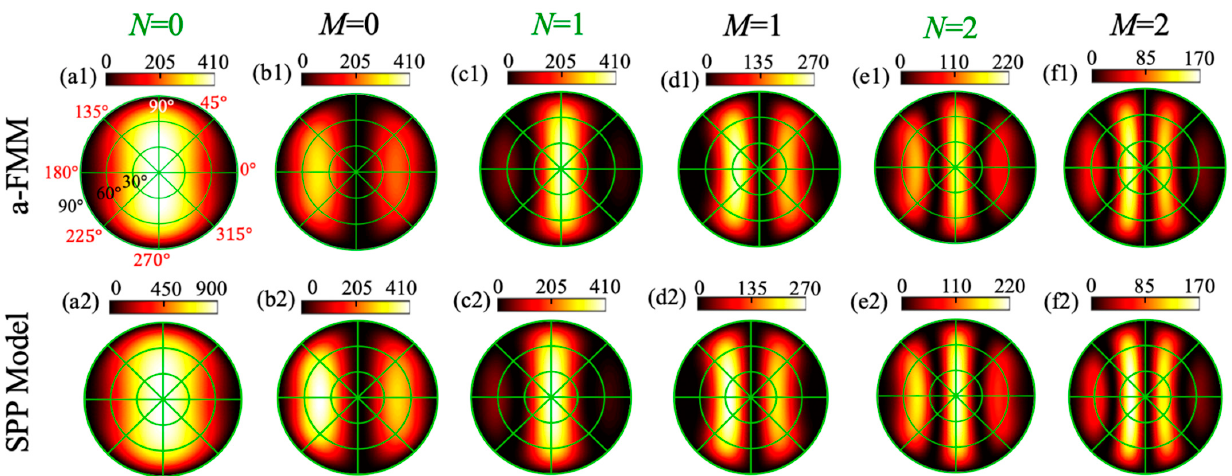
Figure 6. Angular distributions of the far-field emission P ( θ , ϕ ) of the rectangular-aperture nanoantenna obtained at the antenna resonance (the aperture length L satisfies Eqs. (14) and (15)) on a hemisphere in z > 0 region (the water side). (a) N = 0, L = 124 nm . (b) M = 0, L = 314 nm . (c) N = 1, L = 514 nm. (d) M = 1 , L = 704 nm . (e) N = 2, L = 904 nm. (f) M = 2, L = 1094 nm . The results are obtained at the first six resonance peaks shown in Figure 2(b) for λ = 1 μm, D = 30 nm and d = 63 nm . The first and second rows are obtained using the full-wave a-FMM and the SPP model, respectively. The polar angle θ and azimuthal angle ϕ correspond to the superimposed green circles and radial lines, respectively.